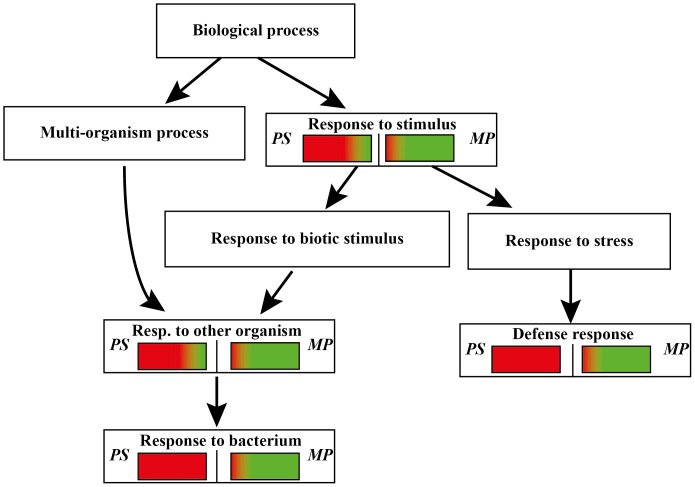
GO analysis of Arabidopsis commonly expressed genes upon Pseudomonas syringae (PS) infection and Myzus persicae (MP) herbivory.Red color indicates up-regulation, green color indicates down-regulation.